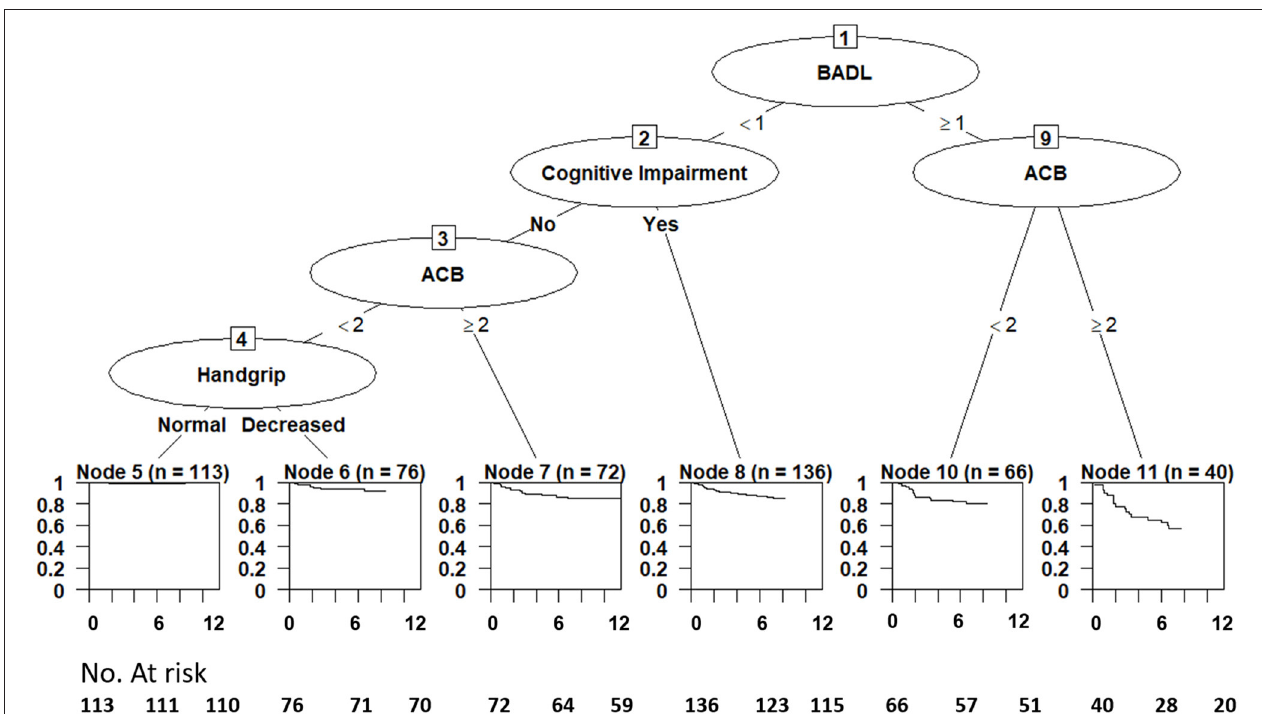
FIGURE 2 | Survival tree of study risk factors showing 1-year mortality among patients carrying the leaf node combinations of study risk factors. ACB, anticholinergic cognitive burden; BADL, basic activities of daily living.